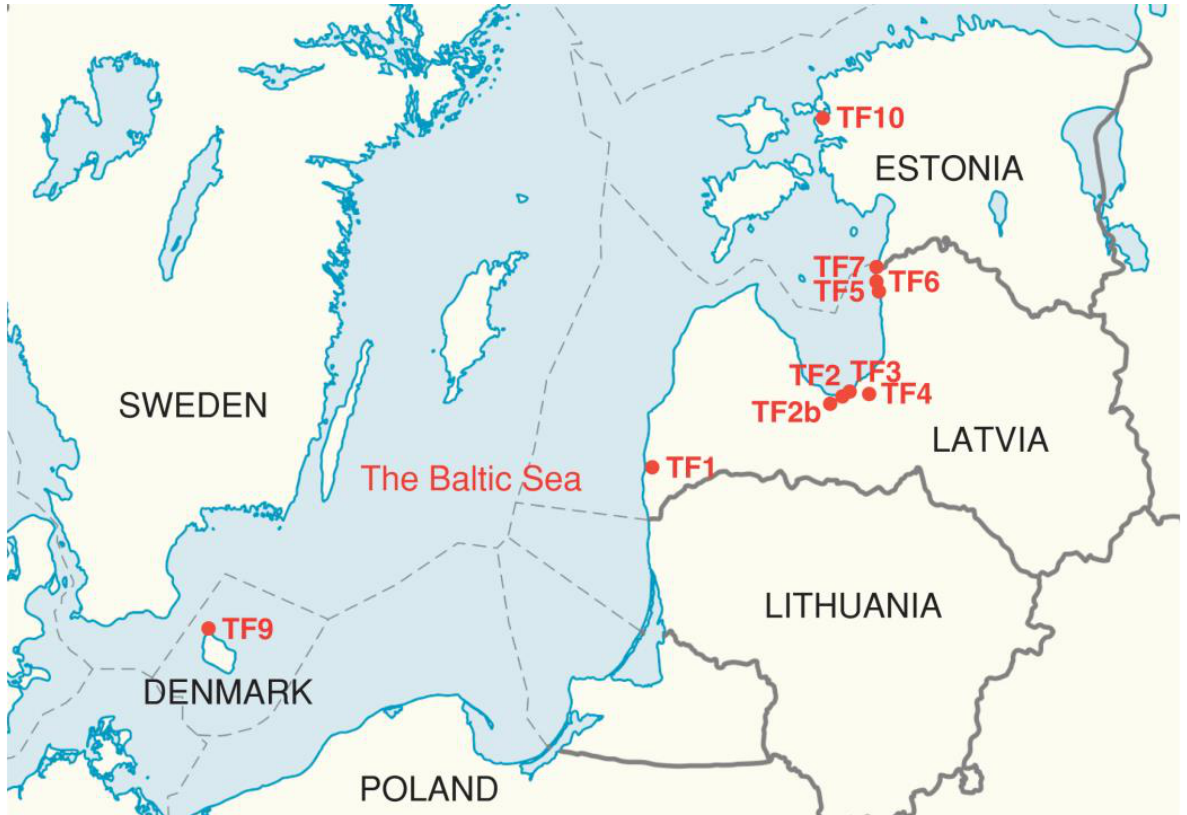
Figure 1. Map of the Baltic Sea region indicating the locations of the analyzed wild Trifolium fragiferum populations. TF1 to TF10 indicate different populations.